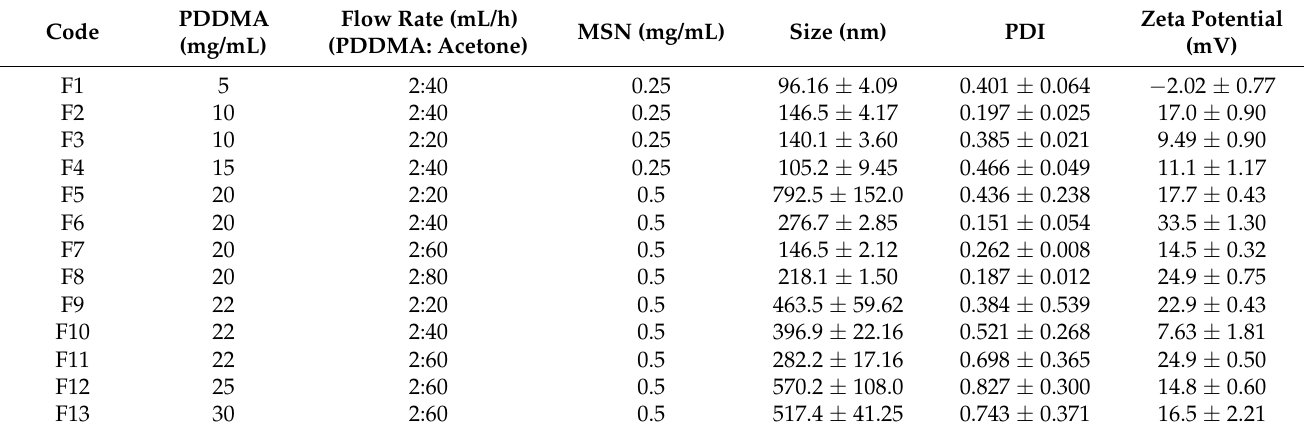
Table 1. Microfluidics parameters for PDDMA coating and characterization results with DLS.